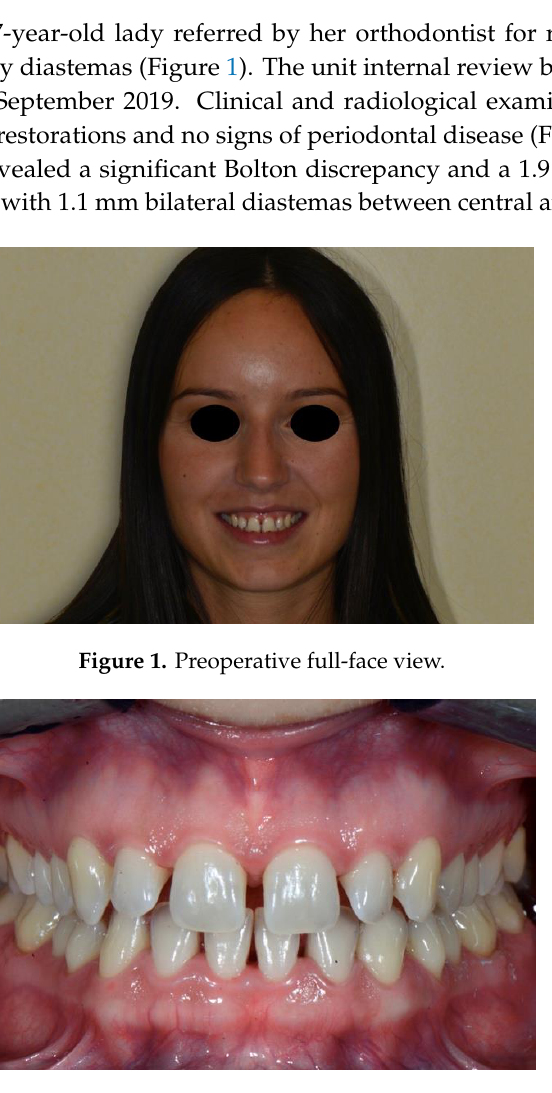
Figure 2. Preoperative retracted